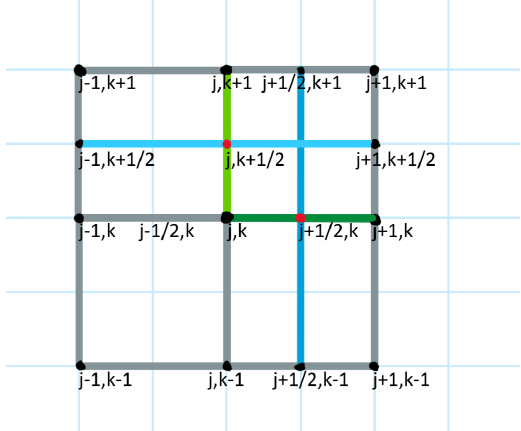
, and F . The green lines represent the deriva- j + 1 2 , k j , k + 1 2